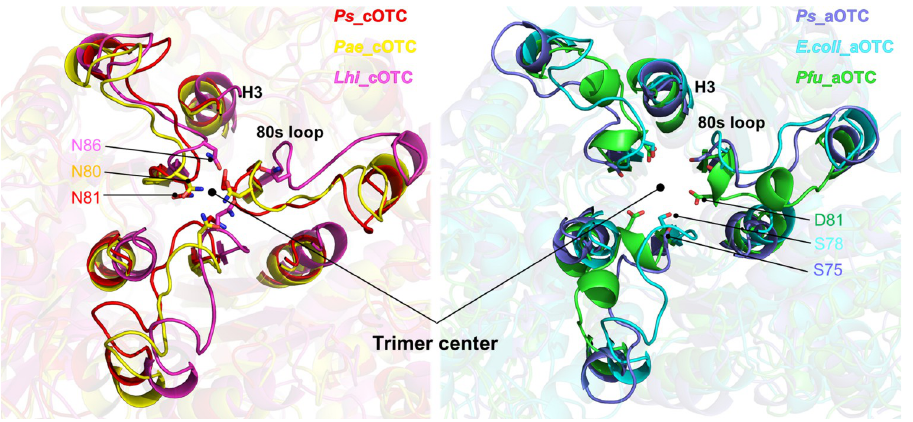
Fig 7. Superposition of the trimer of OTCs. The trimer structures of each orthologue from BLAST were superposed against Ps _cOTC and Ps _aOTC for each group. The H3 and 80s loops around the trimer center of each orthologue were highlighted with different colors. The closest residue to the trimer center from each OTC is indicated by sticks.